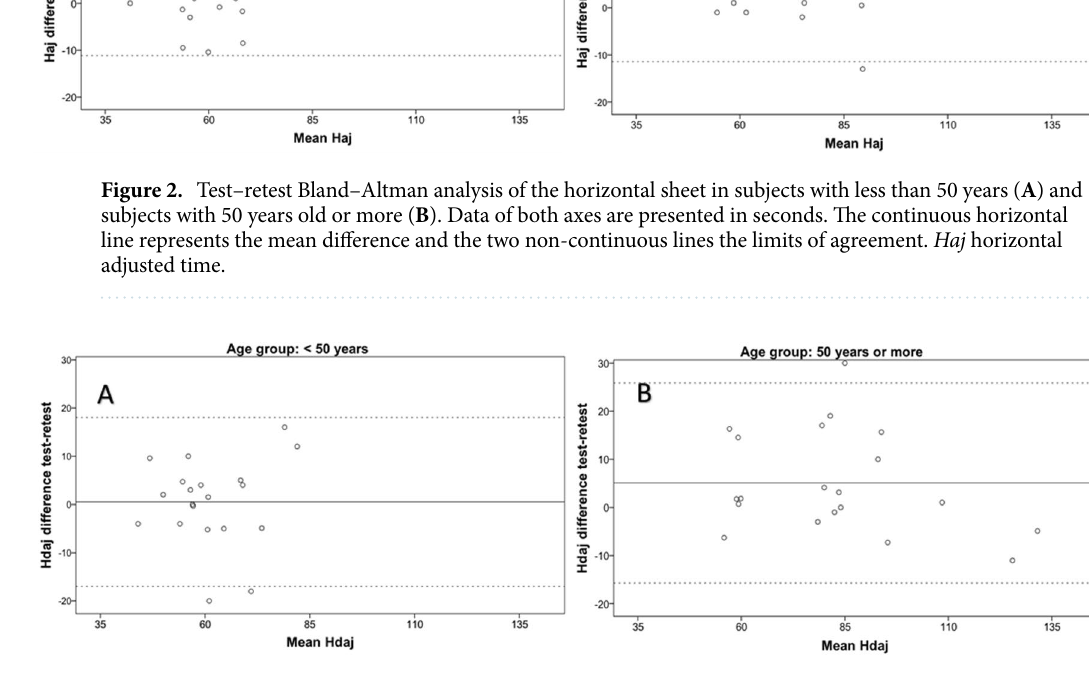
Figure 3. Test–retest Bland–Altman analysis of the horizontal distractor sheet in subjects with less than 50 years ( A ) and subjects with 50 years old or more ( B ). Data of both axes are presented in seconds. The continuous horizontal line represents the mean difference and the two non-continuous lines the limits of agreement. Hdaj horizontal distractor adjusted